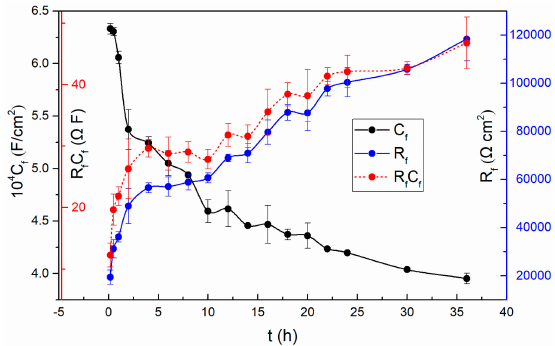
Figure 5. The variation of R f , C f and R f C f with time for TC11 alloy in 0.01 M Na 2 SO 4